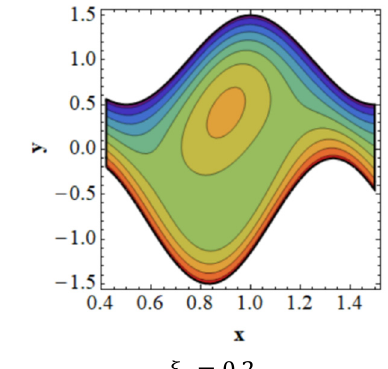
𝐵𝑟 = 2.0 Figure 10. Consistency of streamlines for values of 𝐵𝑟.